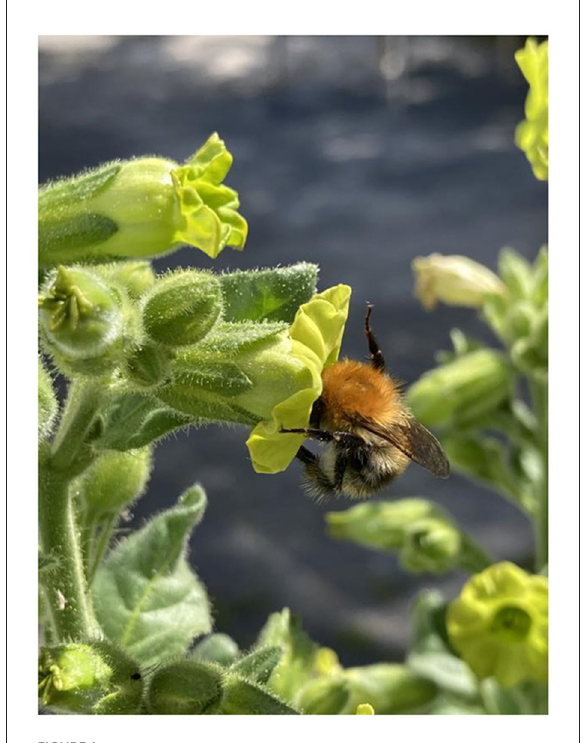
FIGURE1 A Bombus pascuorum bee visiting a Nicotiana rustica flower. Image credit: Marjan